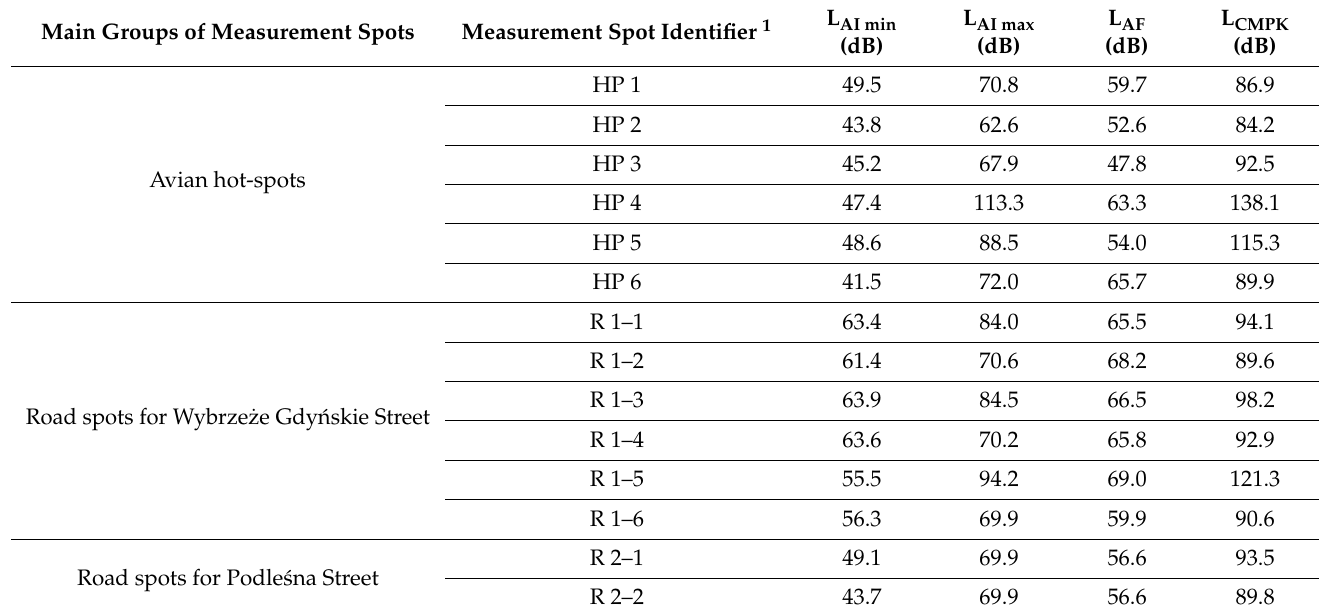
Table 3. The results of sound level measurements performed in June 2021 for avian hot-spots and road spots within the NATURA 2000 area (our own